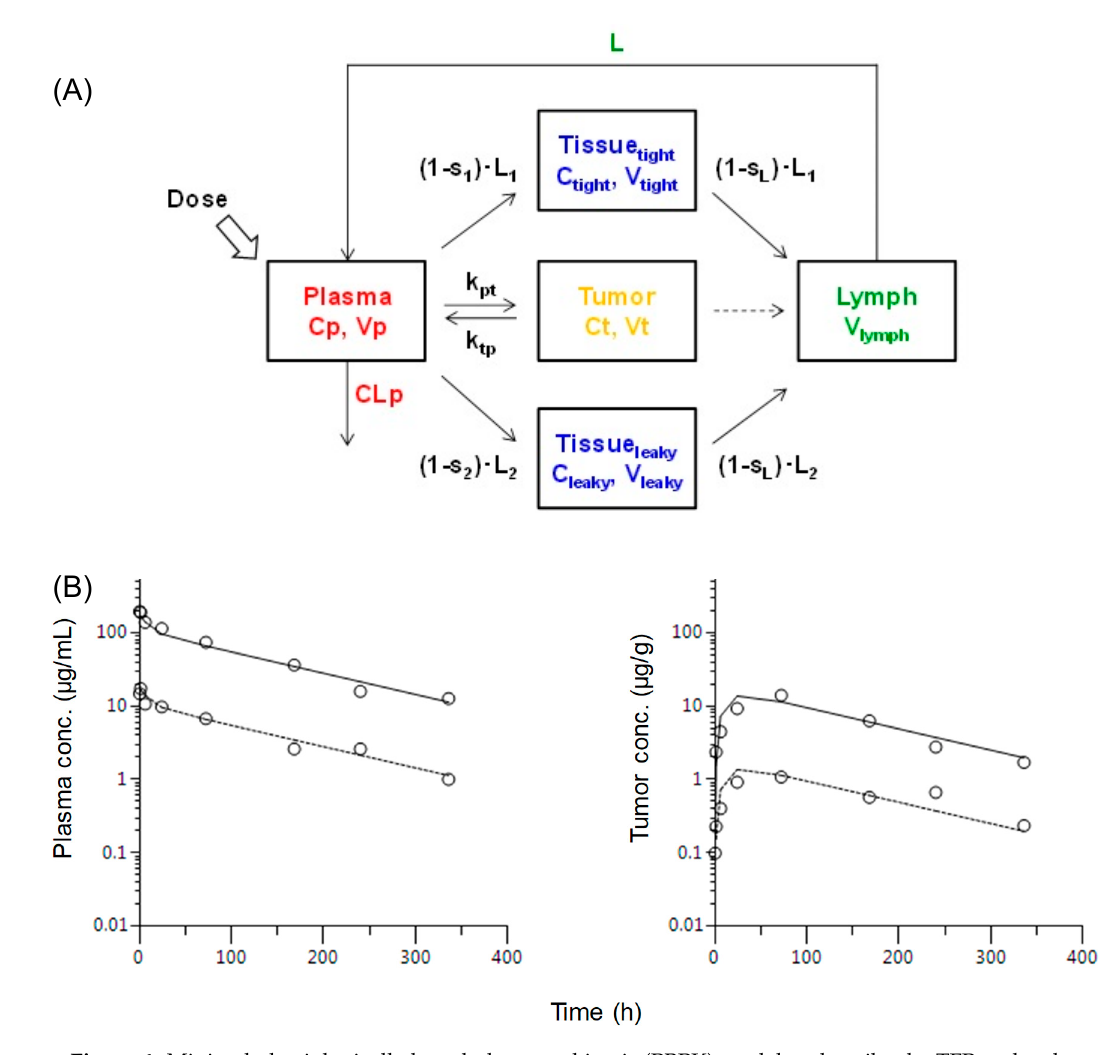
Figure 4. Minimal physiologically based pharmacokinetic (PBPK) model to describe the TFP molecule exposure in plasma and tumor: ( A ) The minimal PBPK model to describe the TFP exposure. ( B ) The experimental data (mean value, open circle) and minimal PBPK model based fitting pharmacokinetic profile in plasma and tumor in mice after a single i.v. administration of TFP at doses of 1 (dotted line) and 10 (solid line) mg/kg. Table 3. The pharmacokinetic parameters used in the minimal PBPK model in mice . Parameter